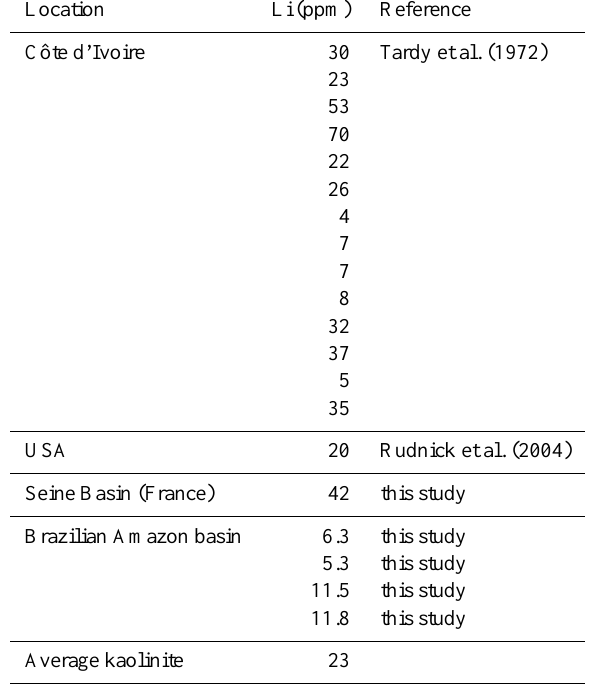
Table 1. Li concentrations measured in kaolinite (Tardy et al., 1972). These clays contain 0.2%MgO (Tardy et al., 1972). On aver- age, the Li level for kaolinite is estimated to be 23ppm. For compar- ison, average Li content for smectite is found to be 27ppm (Tardy et al., 1972) and 22ppm for granite (Teng et al., 2009). Location